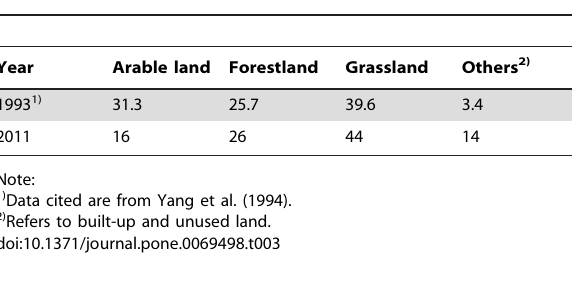
Table 3. Land use in the Liudaogou watershed (%) in 1993 and